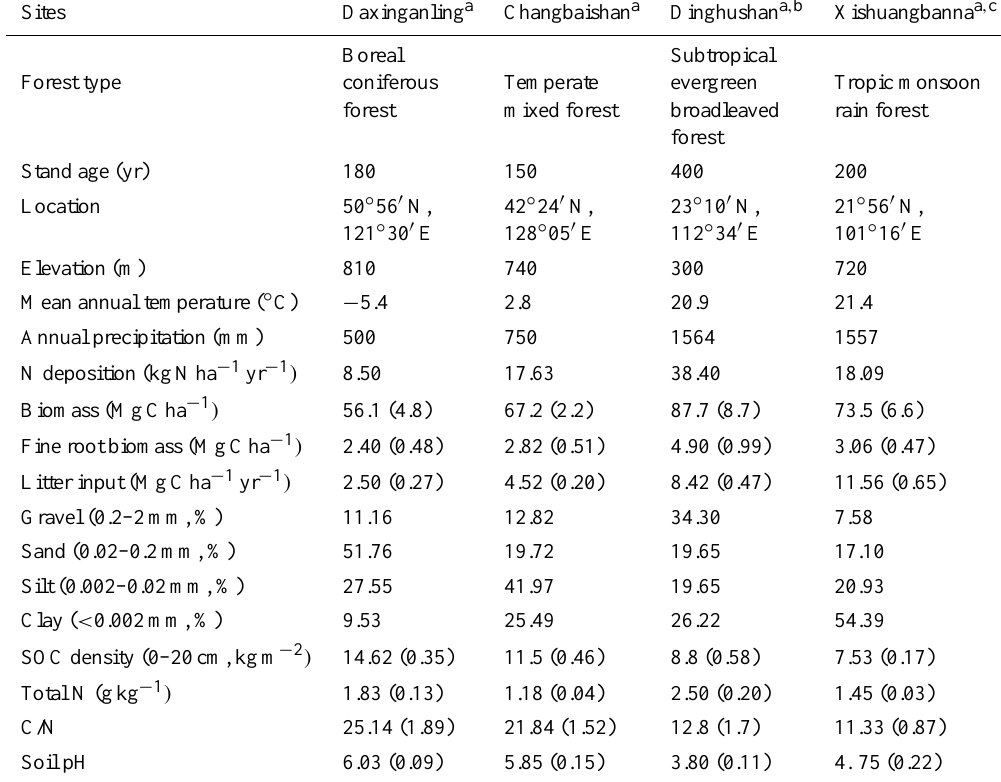
Table 1. Stand characteristics and surface soil (0–20cm) properties of the four old-growth forest sites.